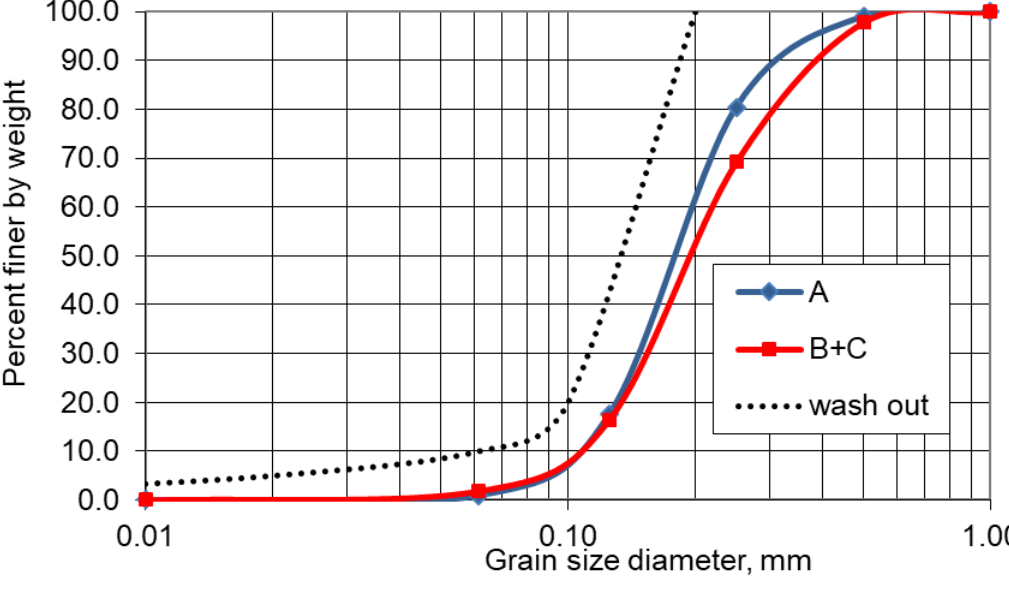
Figure 11. Grain size distribution curve of soil shaken and washed out from nonwoven geotextile samples.